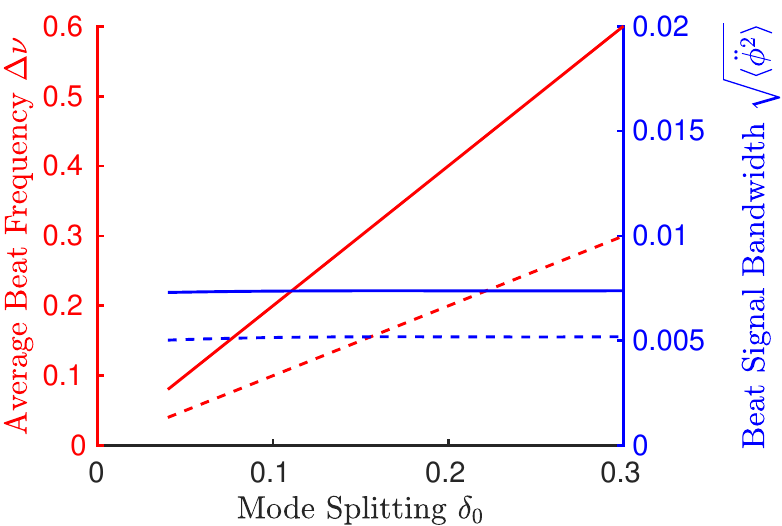
Figure 5. Enhanced (solid) and non-enhanced (dashed) sensor response curves. The average beat frequency (left axis, red) shows Equation (33) plotted as function of the applied mode-splitting. The result of using the enhancement factor of ∂ψ / ∂ ∆Ω | 0 = − 0.5 acts to increase the sensitivity response, S (observed as the slope of the average beat frequency curve), without causing the noise to diverge as characterized by the beat signal bandwidth, Equation (32) (right axis, blue). 150 round- trips were used in these calculations, without coupling, and gain parameters of α 0 = 1, γ = 0.05, and W s =